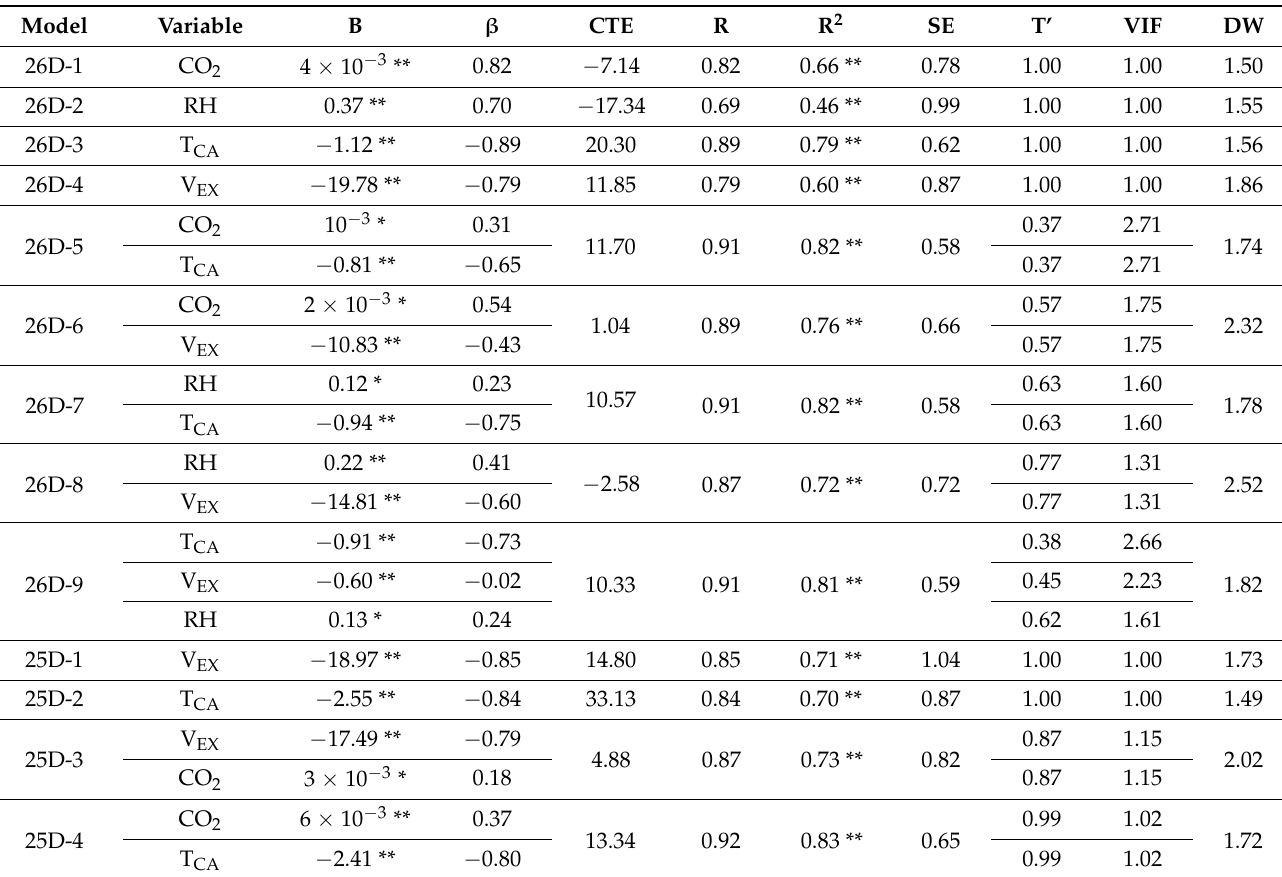
Table 4. Non-standardized coefficients (B), standardized coefficients ( β ), constants (CTE), correlation coefficients (R), adjusted determination coefficients (R 2 ), standard errors (SE), collinearity statistics (T’ and VIF) and Durbin Watson statistics (DW) for the estimation of NH 3 from multiple regressions with the variables (V): CO 2 , RH, T CA and V EX for mean daily data (D) and T S 26 ◦ C or 25 ◦ C.